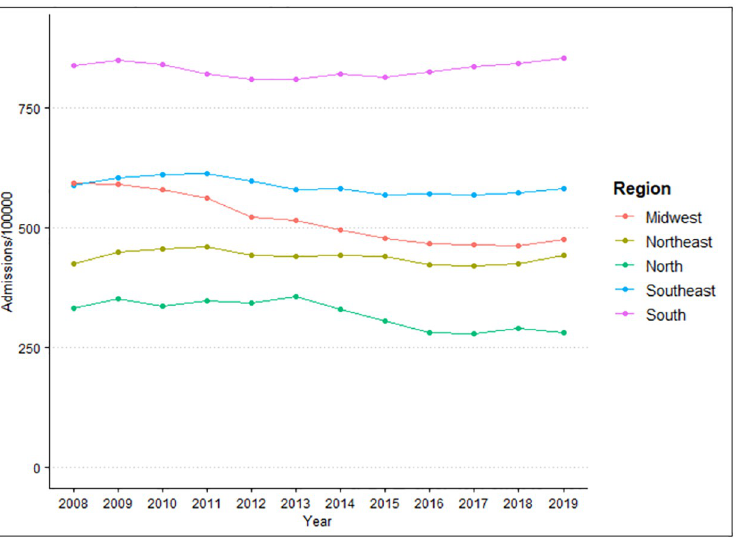
Fig 1. Number of hospital admissions caused by cardiovascular diseases per 100,000 inhabitants according to region of residence in the period from 2008 to 2019. Source: Brazilian Institute of Geography and Statistics (IBGE) and Ministry of Health–Hospital Information System of the Unified Health System (SIH/SUS) 2021.